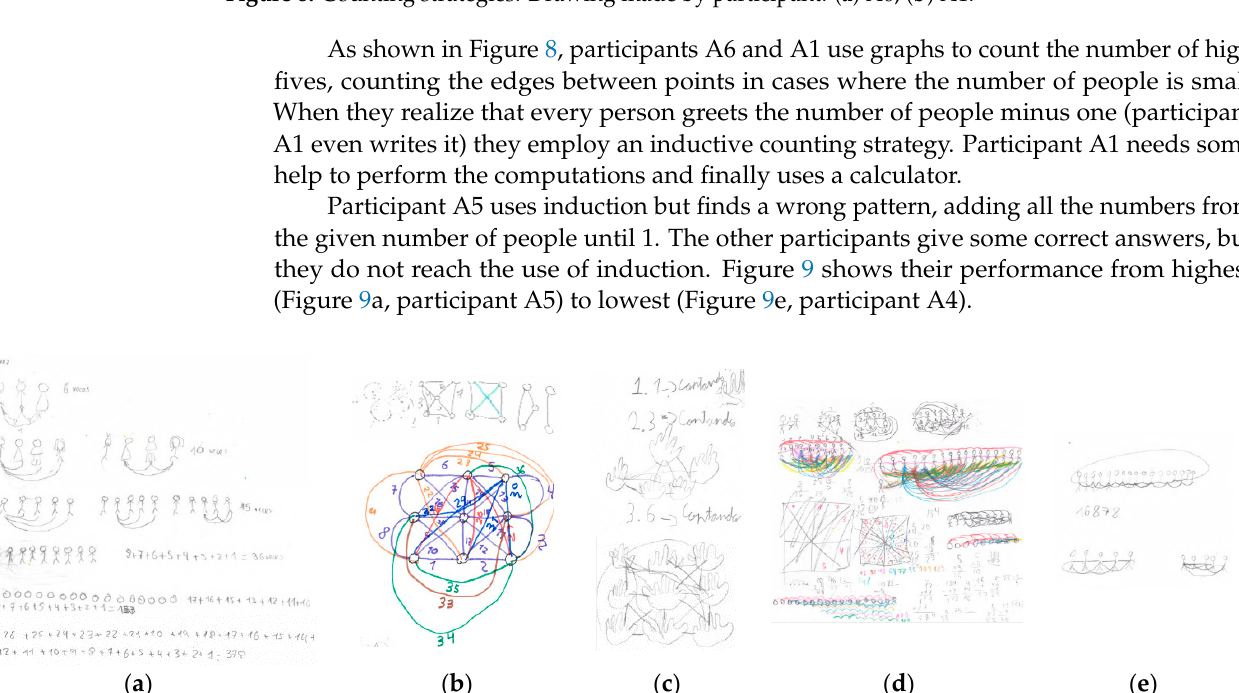
( e ) Figure 10. Tracing Eulerian cycles. Drawing made by participant: ( a ) A3; ( b ) A5; ( c ) A4; ( d ) A6; ( e ) A7. Afterward, we gather their work in common, and every participant shows and ex- plains his/her graphs to the others. We then encourage them to create more graphs with Eulerian cycles and other graphs with no Eulerian cycles. We show some of the created graphs in Figure 10. We give to the participants a template with nine points (see Appendix A) and ask them to join all the points using only four straight lines, without lifting the pencil from the paper and crossing only once through each edge. All participants solve the puzzle cor- rectly, except participants A1 and A2 who do it with help of the researcher. Participants use the trial and error method again, together with use of symmetry. In this session and the following ones, participants A1 and A2 solve all the activities with the help of the researcher; therefore, we do not include the rest of their performance. 3.5. Seven Bridges of Köningsberg After telling the story of the Seven Bridges of Köningsberg, we give the participants an image [23] with the representation of the city and pose some questions (see Appendix A). Figure 11 shows the participants’ attempts to find a closed walking path through the four areas of the city, crossing each bridge only once (Eulerian cycle).